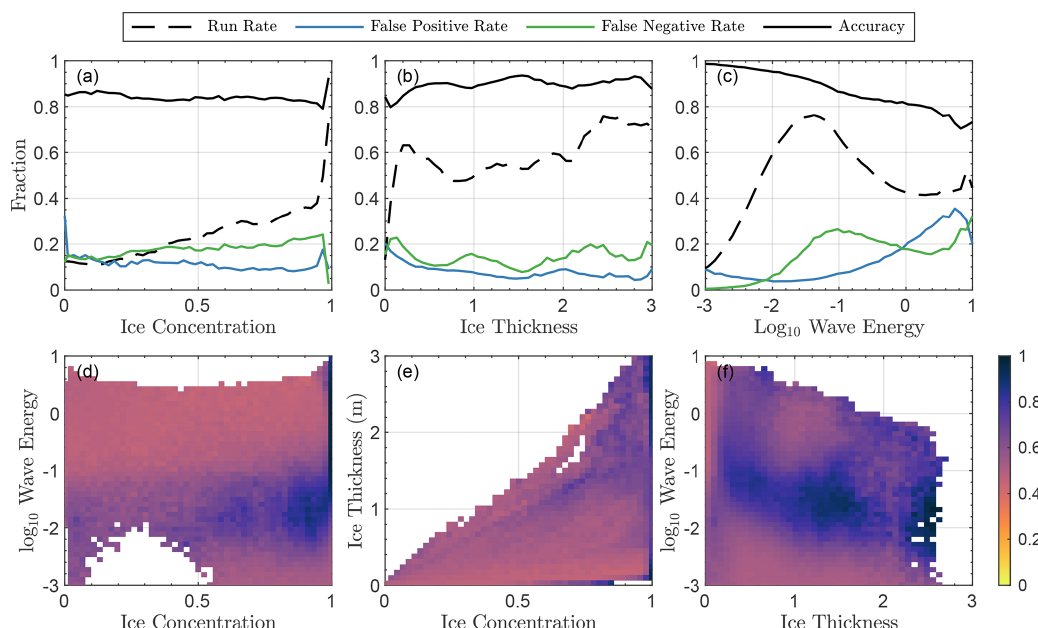
Figure 1. Performance of input classification for NN-WIFF. (a) Percentage of times the classifier runs (run rate, dashed black), calls the histogram network incorrectly (false positive rate, blue), or fails to call the histogram network (false negative rate, green) and overall accuracy (black) for the input classifier as a function of sea ice concentration. (b, c) Same as (a) for (b) sea ice thickness and (c) log 10 wave energy. (d–f) Heat map of average classifier accuracy as a function of (d) ice concentration and log 10 wave energy, (e) ice concentration and ice thickness, and (f) ice thickness and log 10 wave energy. Regions of phase space with fewer than 75 input vectors (less than 0.005% of input data) are uncolored or